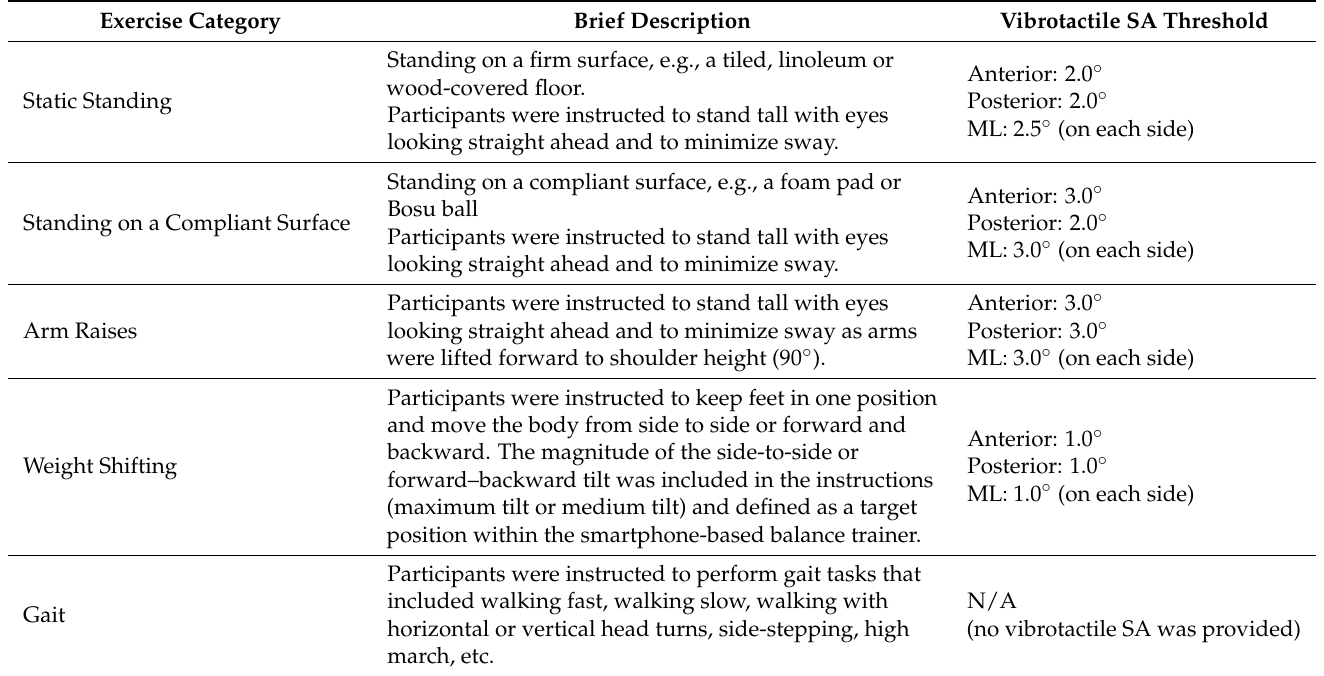
Figure 3. Schematic demonstrating the architecture of the vibrotactile feedback algorithm used in the smartphone-based balance trainer. For each exercise, tilt angles and angular velocities extracted from the Core Motion SDK were used to determine when the vibrating actuators (tactors) should be activated. A control signal (trunk tilt plus one half the angular rate of tilt [42]) was used for static standing, compliant standing, and arm-raise exercises. However, the control signal only considered trunk tilt for the weight shifting exercises. When a participant’s control signal exceeded a pre-defined threshold in a particular direction (Table 2), the tactor bud in the direction of movement was activated via an audio signal to provide a vibrotactile cue to the participant. Table 2. Participants were asked to perform home-based exercises from the following five categories during the two periods of six weeks of